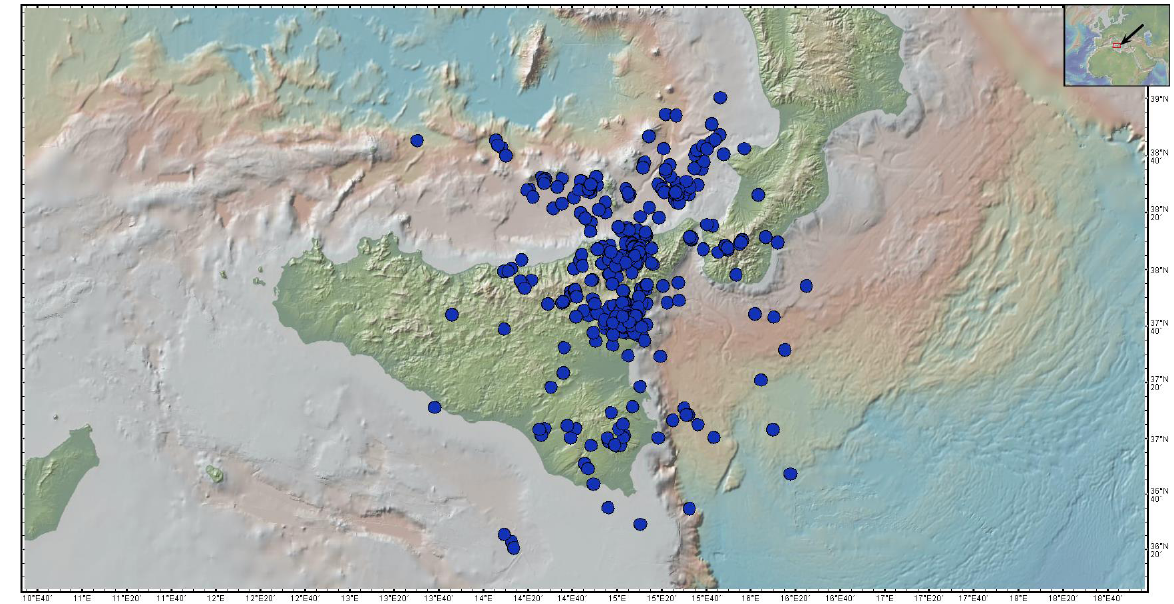
Figure 11. Maps of the 452 earthquakes occurred between June and October 2014, used in the TOMO-ETNA experiment.